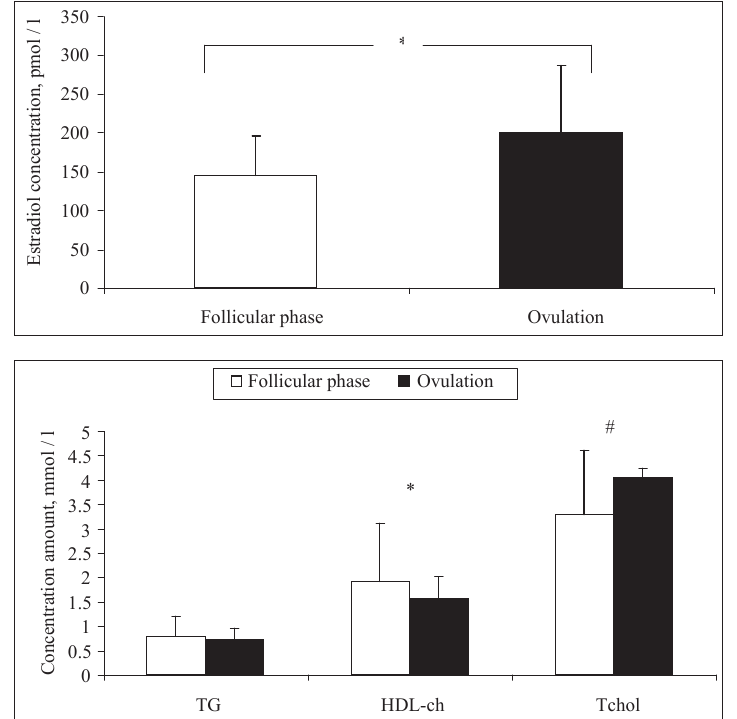
Figure 3. Concentration amount of serum total cholesterol (Tchol), high density lipo- protein cholesterol (HDL-ch), triglyceride (TG) in the ovulation and follicular phase groups (p <